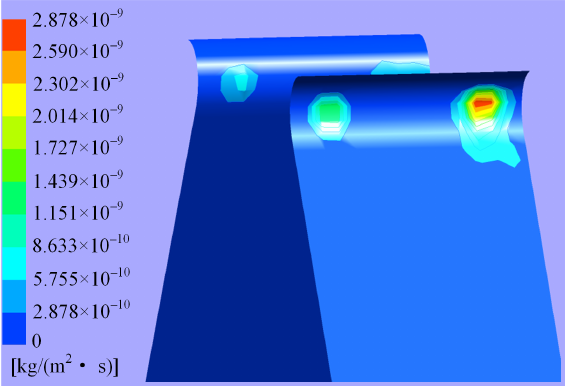
Figure 12. Erosion rates of the receiver’s guide